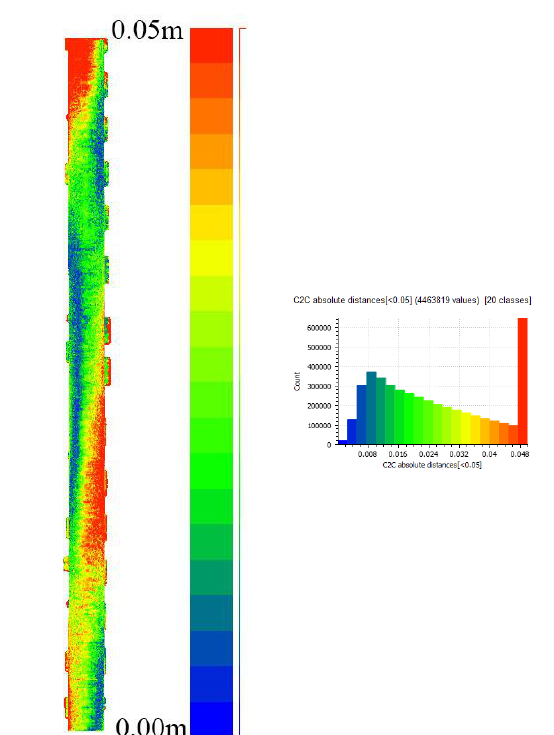
Figure 10 Cloud to cloud (NavVis and Leica) computation top view results in CloudCompare (long corridor) The results show that the corridor’s wall on the point cloud is the critical area because of the bending effect. Also, if we check the inside of the corridor’s point cloud it can be seen that the ground points are relatively in good position (in Z direction) (Figure 11).